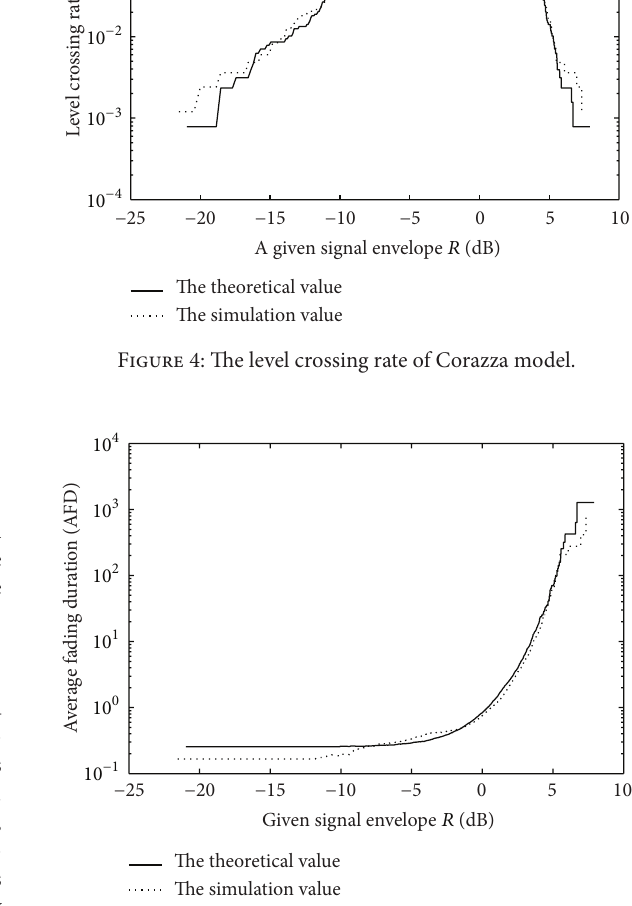
Figure 5: The average fades duration of Corazza